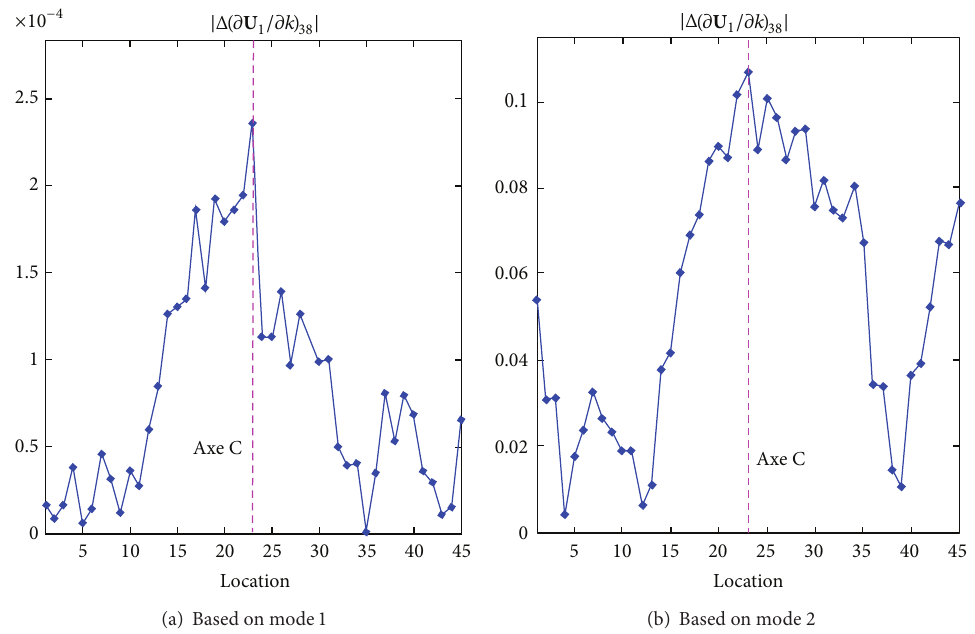
Figure 11: Damage localization in the RC slab for damage # 2 ∗ .